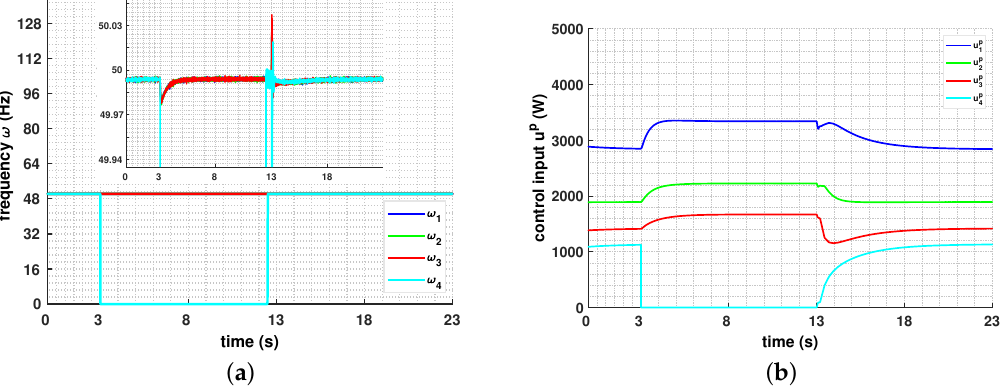
Figure 13. Responses of frequency and active power control input for periodic sampling mechanism